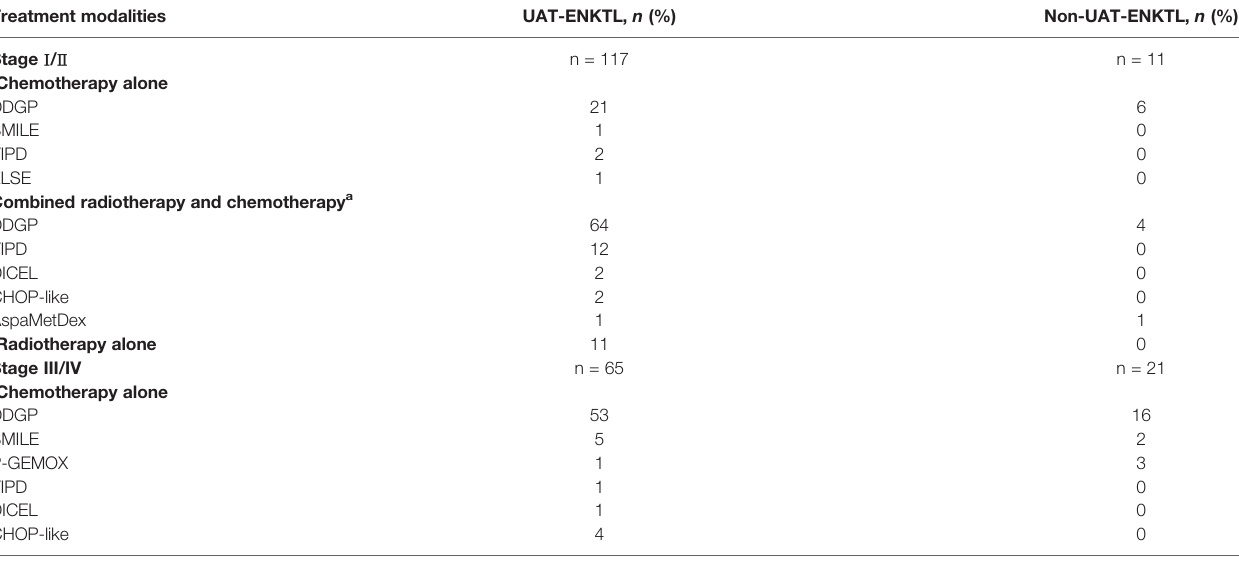
TABLE 1 | Initial treatment modalities based on the subtype and CA staging.